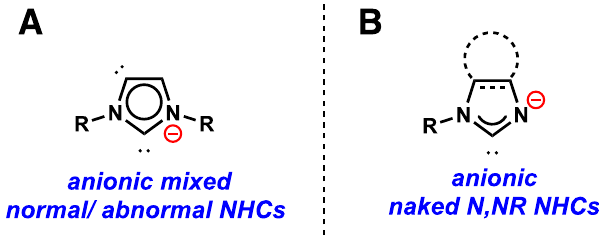
Figure 2. ( A ) Anionic Classical Mixed Normal/Abnormal N -Heterocyclic Carbenes (NHCs). ( B ) Anionic Naked N,NR NHCs.